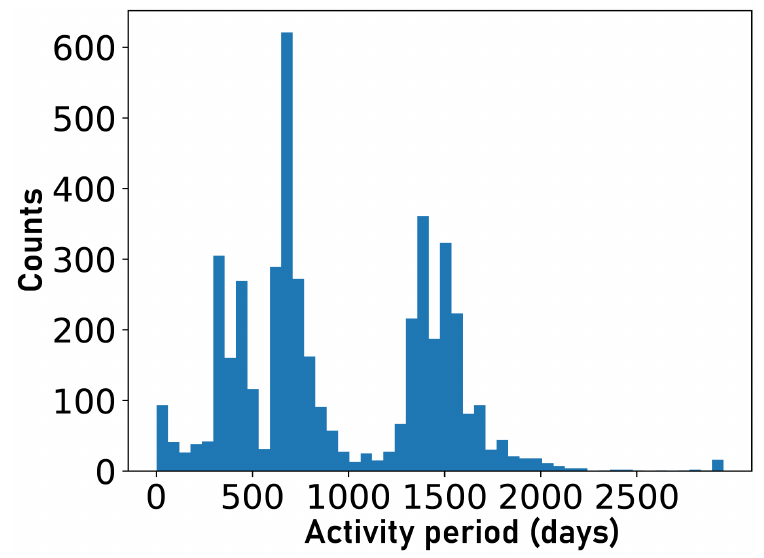
Figure 6. The distribution of Kepler activity cycle candidates found by our smoothness metric, which is defined as light curves whose strongest signal has a p -value < 0.003. Of the 92,084 Kepler light curves which we analyzed, 4455 pass our p -value test and are displayed in this